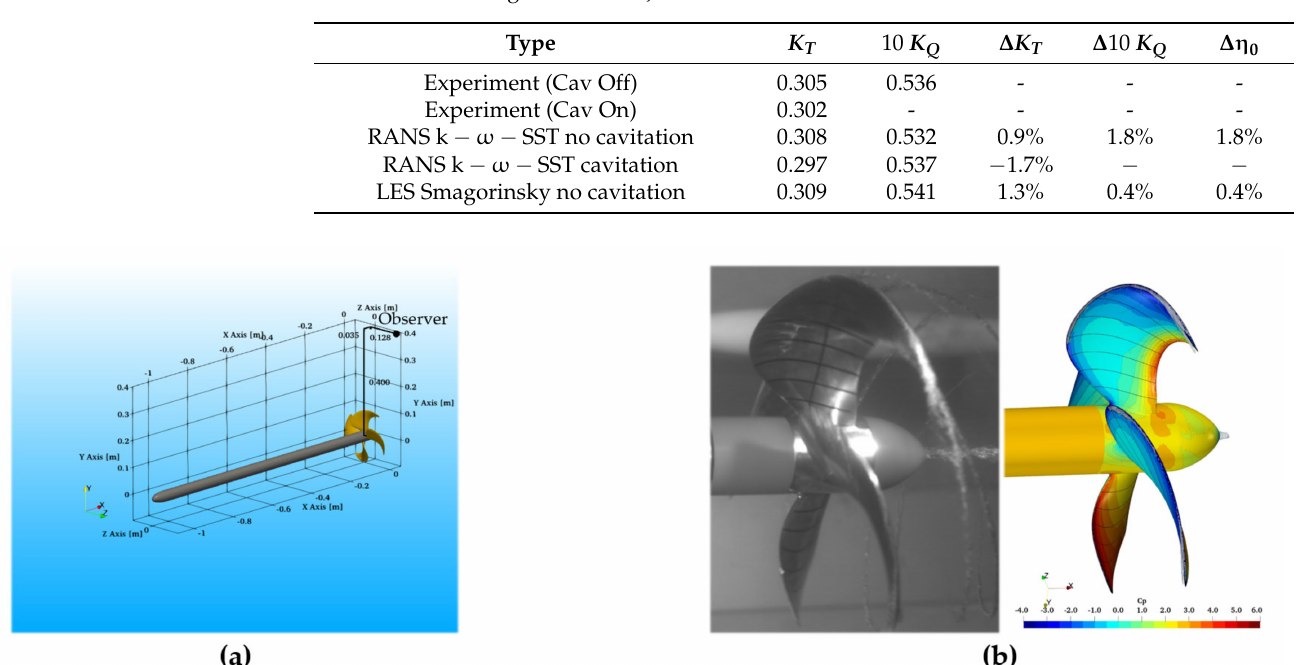
Table 5. P1595: integral values at J = 0.6.